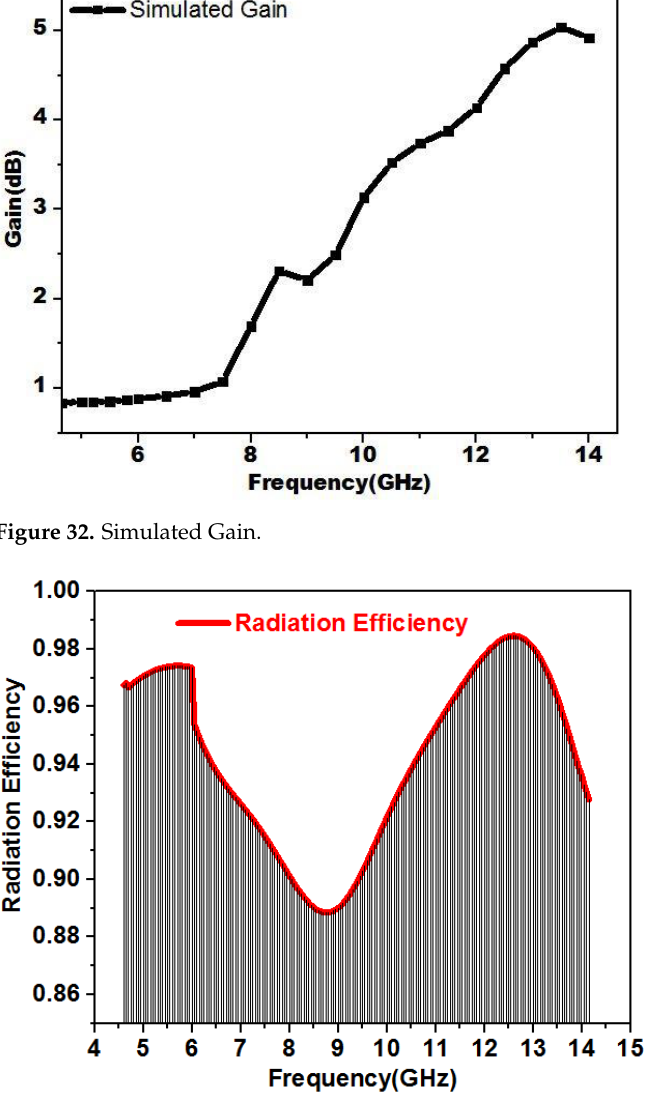
Figure 33. The efficiency of the proposed antenna.